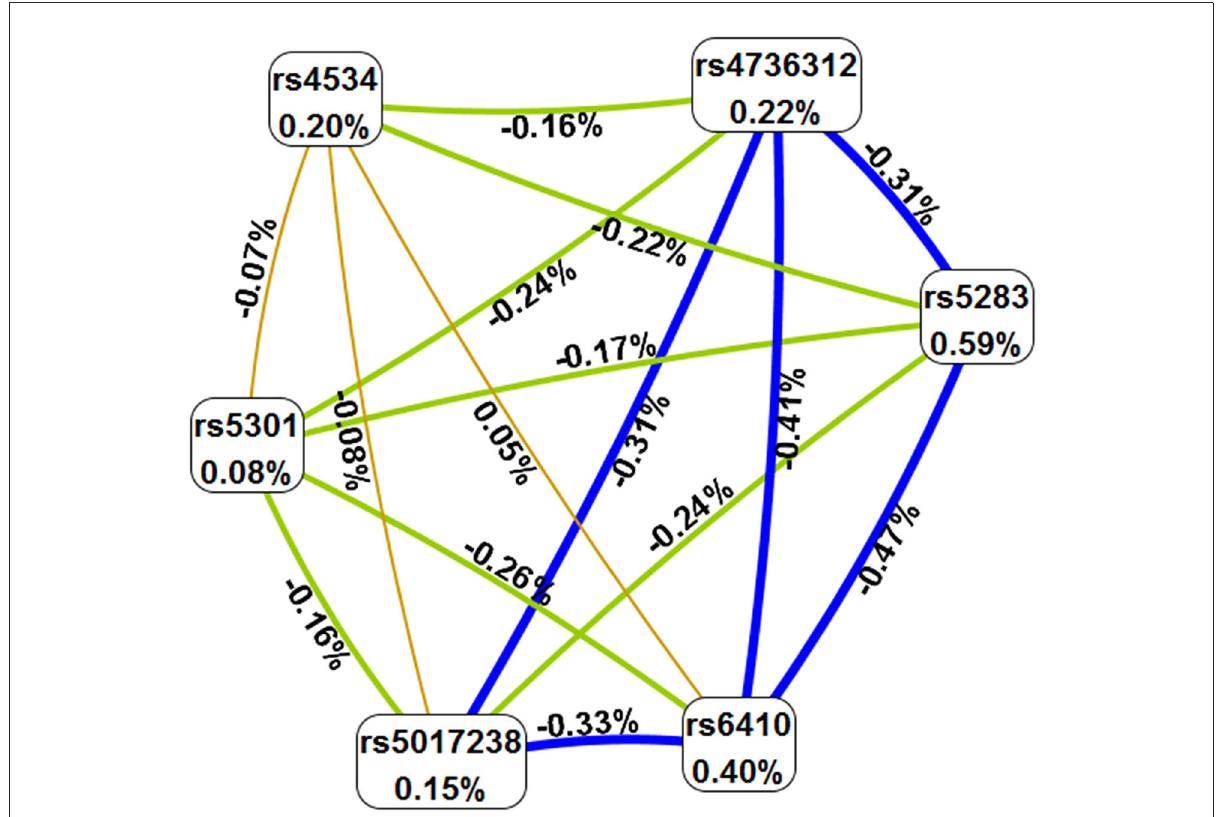
FIGURE1 The SNP–SNP interaction map. Values in nodes represent the information gains of the individual attributes (main effects). Values between nodes are information gains of each pair of attributes (interaction effects). Orange with positive percent entropy indicates a strong synergistic interaction. Light range, blue, and green with negative percent entropy indicate redundancy or